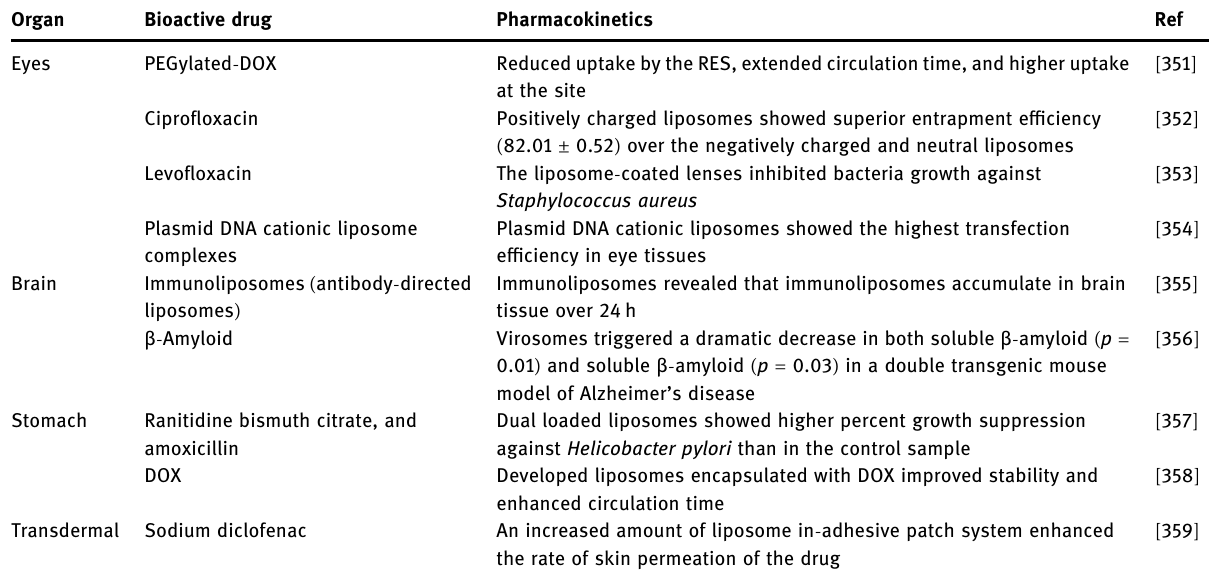
Table 5: Liposomal drug carriers ’ organ targetings and their major pharmacokinetic characteristics Organ Bioactive drug